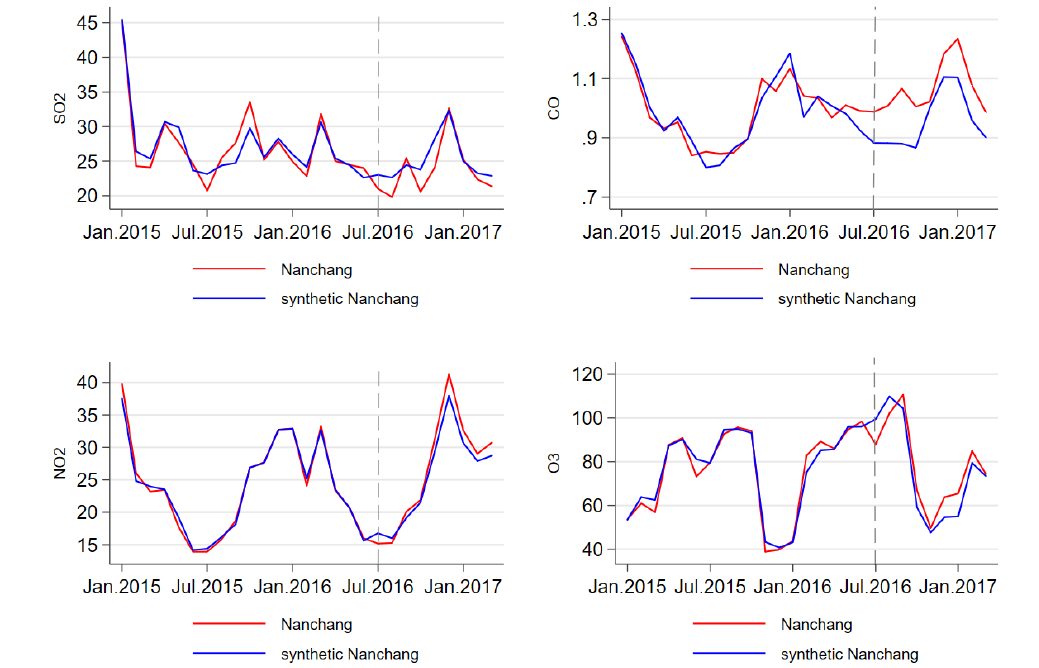
Figure 11. Individual pollutants in treatment regions and synthetic